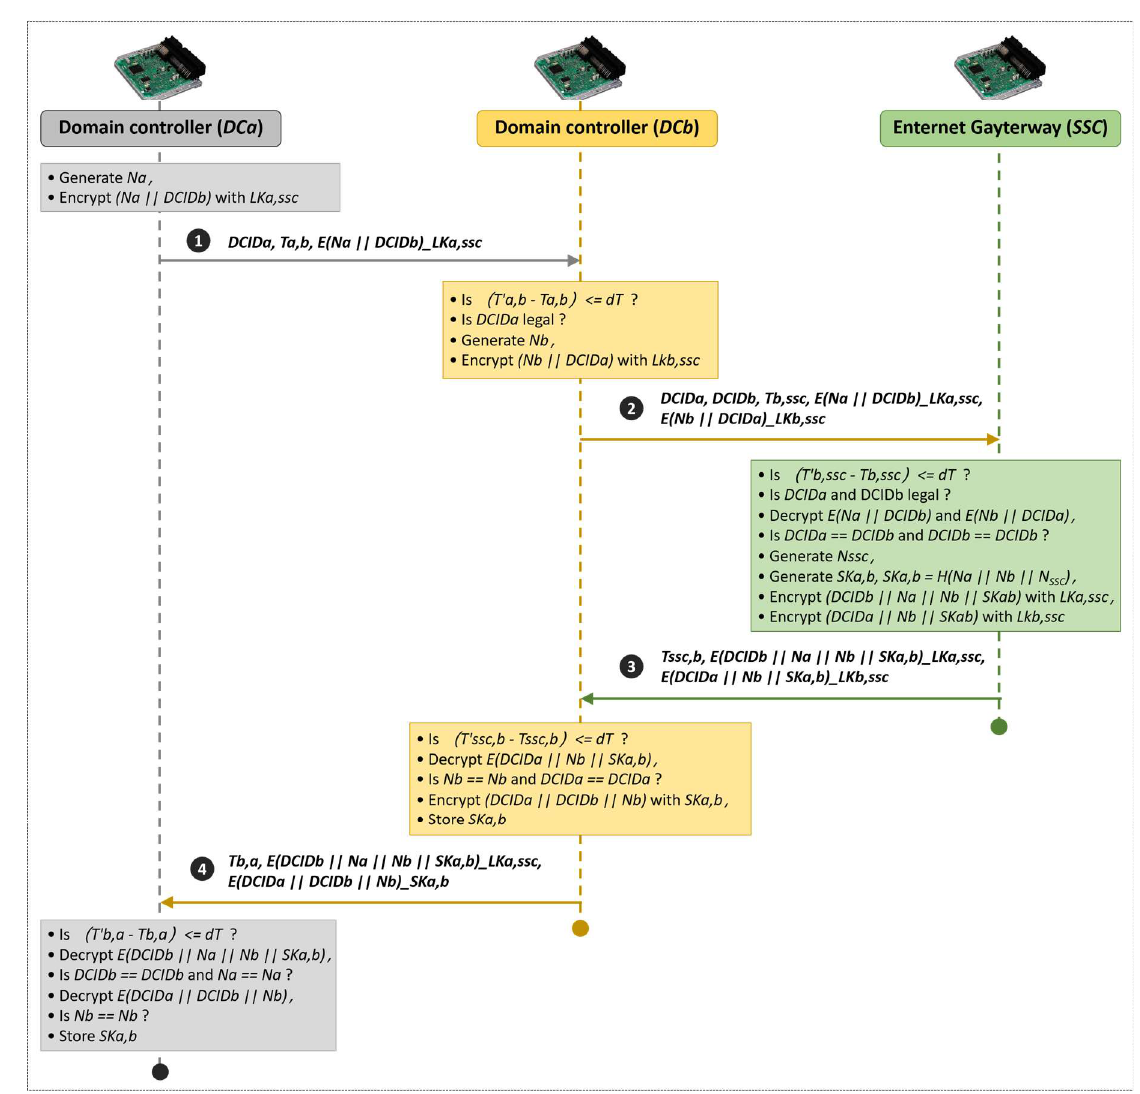
Figure 5. Proposed authentication